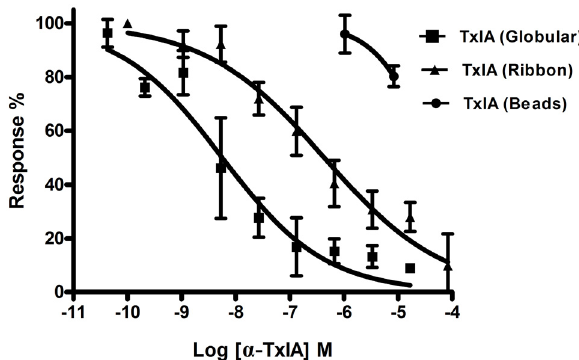
Figure 8. Inhibition concentration-response curves for the isomers of α -CTx TxIA. Values are mean ± SEM from 6 to 10 separate oocytes. Globular, Ribbon and Beads isomers were tested on rat α 3 β 2 nAChRs expressed in Xenopus